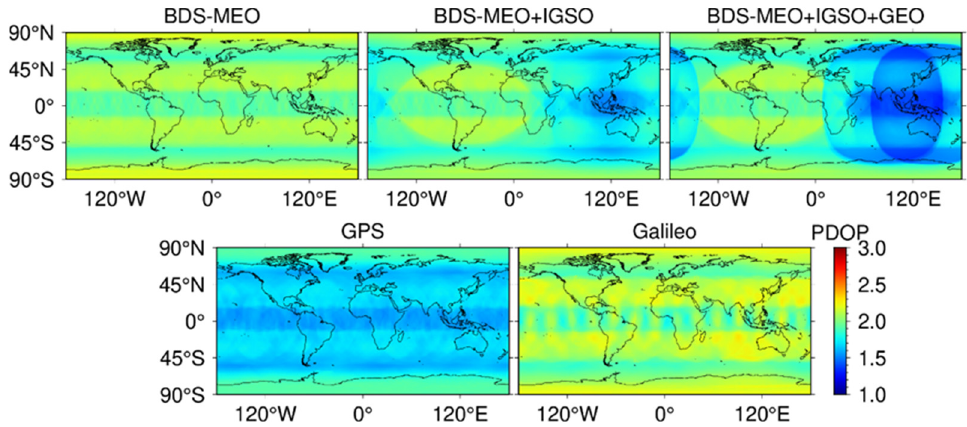
Figure 3. The PDOP for GPS, Galileo, BDS-3-MEO, BDS-3-MEO+IGSO, and BDS-3-MEO+IGSO+GEO.